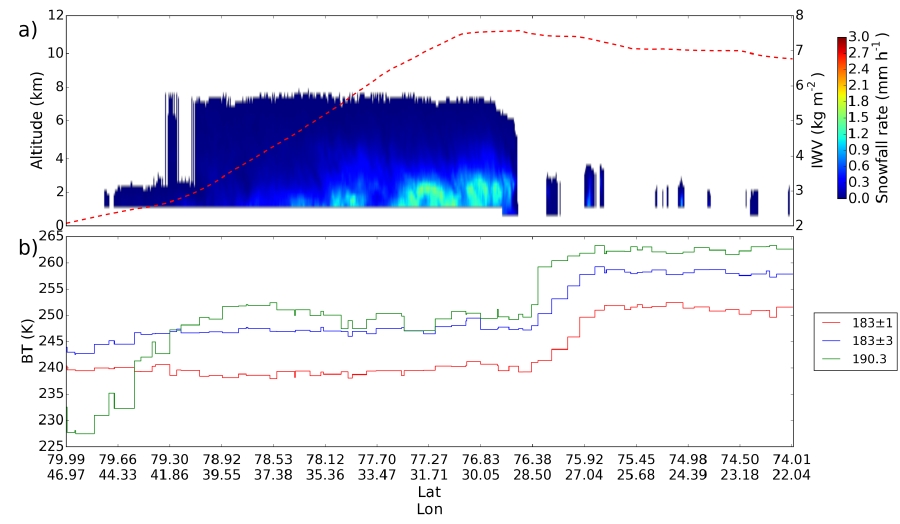
Figure 6. Same as Figure 4, but for the snowfall event located over the Barents Sea on 29 March 2007.